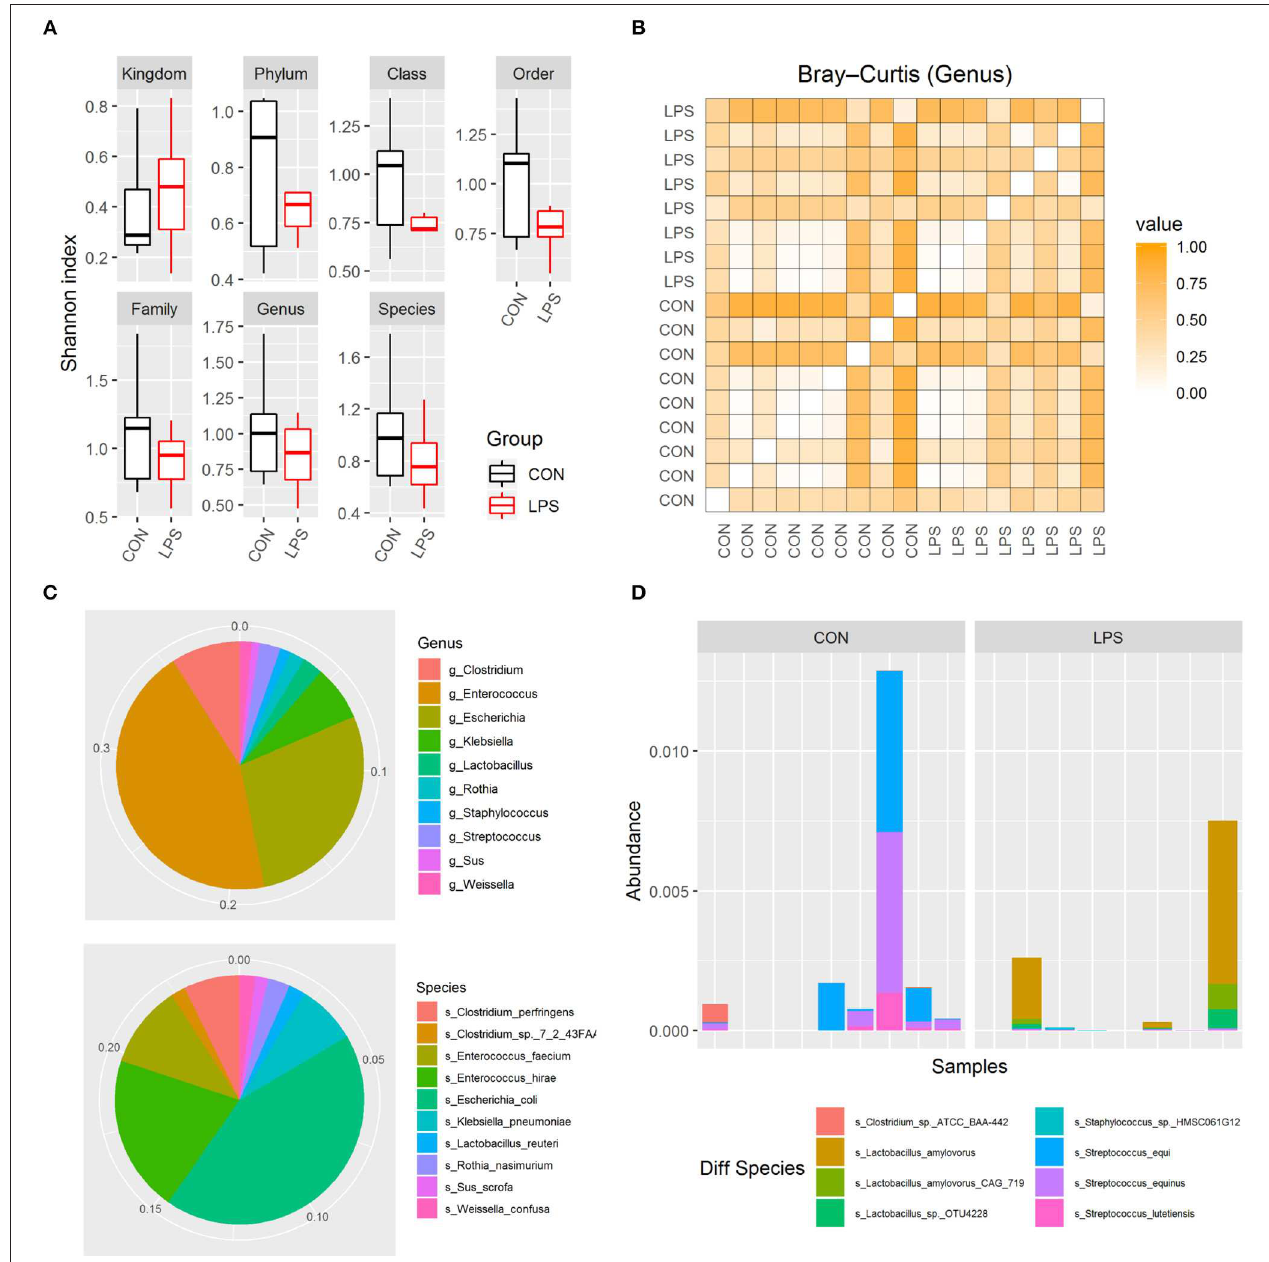
FIGURE 2 | Gut microbiome in LPS and CON groups on postnatal day 5. (A) Boxplot of Shannon index in two groups. (B) Heatmap derived from dissimilarity matrix of Bray–Curtis distances from all 5-day-old pigs. (C) Pie chart of top 10 abundant genus/species in all 5-day-old pigs. (D) Bar plot showing eight differential abundant species between the LPS and CON